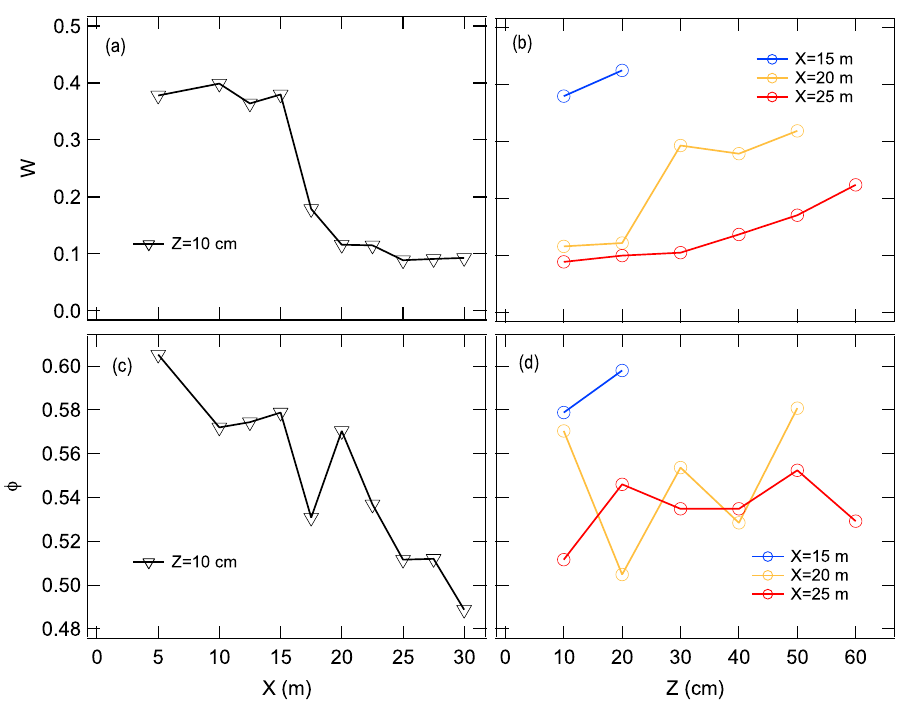
Fig 5. Water content and packing fraction of sand with distance from shoreline and at depth for beach sand sampled at the Tsu site. Panels (a) and (c) depict sample results of water content ( W ) and packing fraction ( ϕ ) at depths ( Z ) 10 cm for each distance from shoreline ( X ). Panels (b) and (d) depict water content ( W ) and packing fraction ( ϕ ) measured at shoreline distances ( X ) of 15, 20, and 25 m.